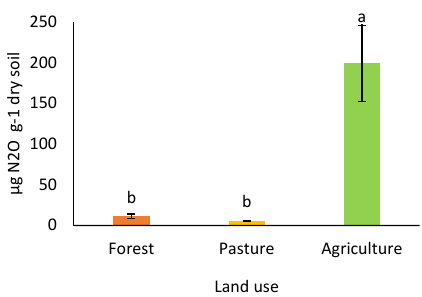
Figure 1. Total N 2 O emissions (µg N 2 O g −1 of dry soil) in soil submitted to land-use systems in the Brazilian Amazon. Different lowercase letters represent the differences evaluated by the Tukey test ( p < 0.05).